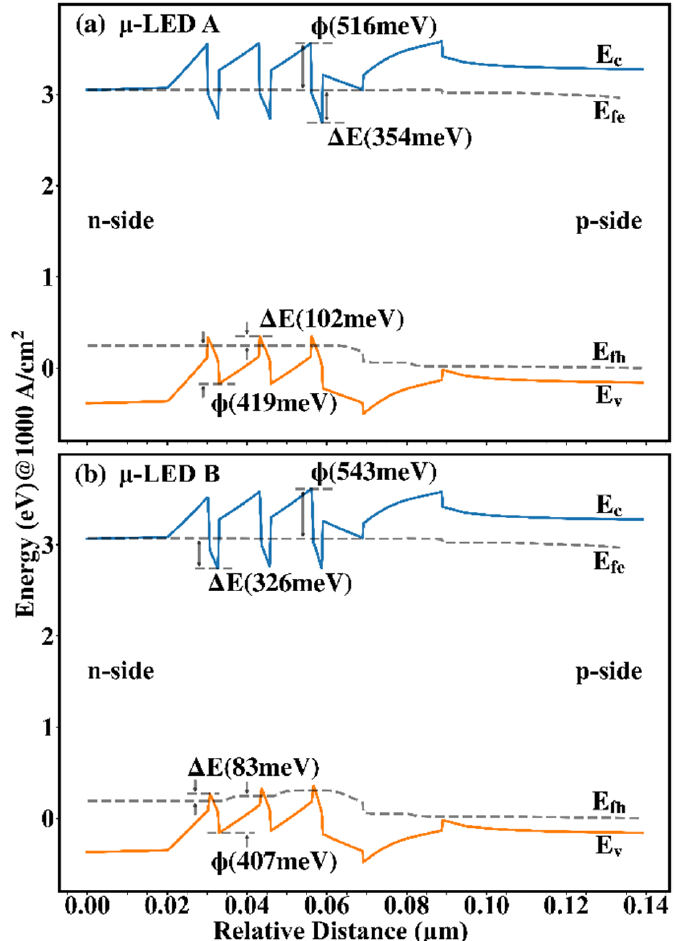
Figure 4. Energy band of ( a ) μ -LED A and ( b ) μ -LED B at 1 kA/cm 2 . Based on Equations (3) and (4), it can be concluded that the − 3 dB modulation band- width is positive relative to 1/ τ , which is positive relative to carrier concentration. Figure 5 shows 1/ τ as a function of relative distance for the two µ -LEDs at 1 kA/cm 2 . In Equation (3), the concentrations of electrons and holes used to calculate 1/ τ are taken from the data at the corresponding locations in Figure 3, which means that 1/ τ is also related to the overlap of the electron-hole distribution. Different carrier concentrations lead to different carrier lifetimes in different QWs, and the short-lived carriers reflect the high-frequency portion of the frequency response, which greatly affects the modulation bandwidth. To facilitate the analysis, the peaks of 1/ τ of the two µ -LEDs are selected and marked in Figure 5. Combining Figures 3 and 4, it can be found that although a higher ∆ E exists in µ -LED A, the improved hole transport makes the peaks of concentrations of electrons and holes of µ -LED B almost coincide. As a result, the peaks of carrier concentrations of µ -LED B and µ -LED A have little difference. Combining Figures 2, 3 and 5, it can be found that although the peak of the carrier concentration of µ -LED B is slightly lower than that of µ -LED A, the huge advantage in the overlap of electron-hole wave functions allows µ -LED B to create a higher peak of 1/ τ